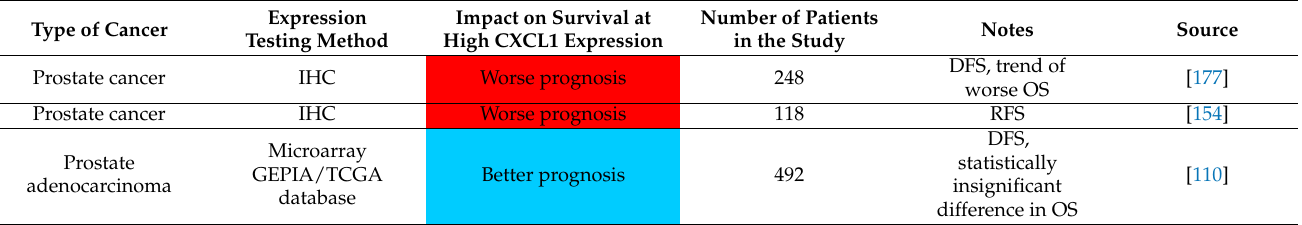
Table 5. Effect of CXCL1 expression level on survival of prostate cancer